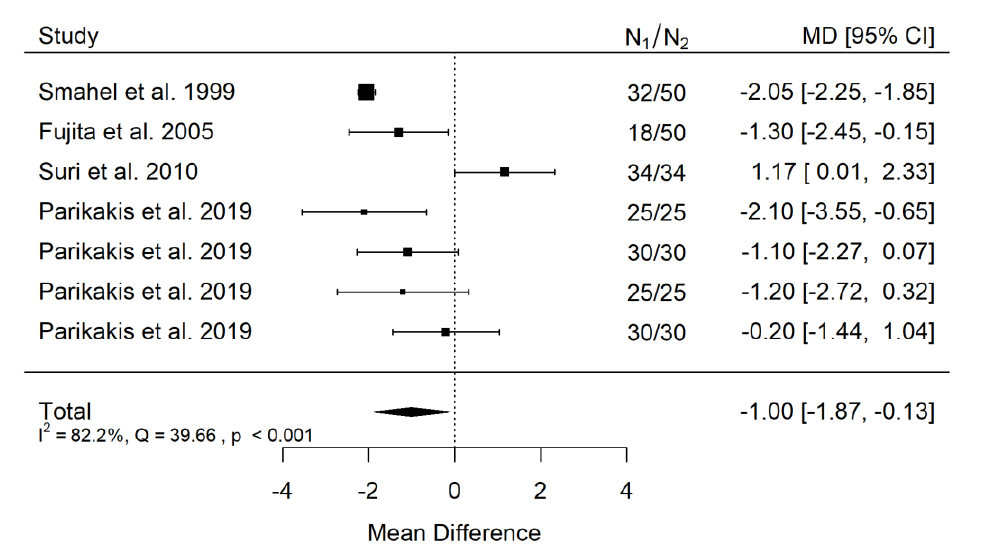
Figure 12. Forest plot of ANB values for the comparison of patients with cleft palate only treated surgically and orthodontically vs. non-cleft healthy population [19,22,29,32,33].